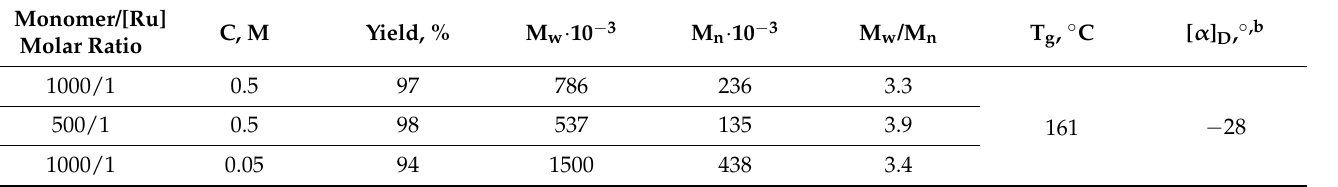
Table 1. Metathesis polymerization of the ester of exo -5-norbornenecarboxylic acid and 1,1 ′ -bi-2- naphthol. a.